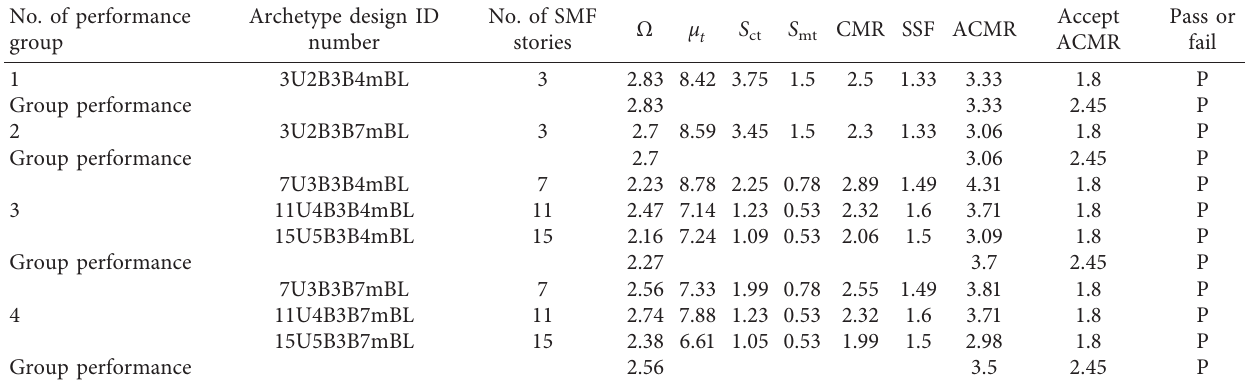
Table 3: Collapse performance evaluation of RCN